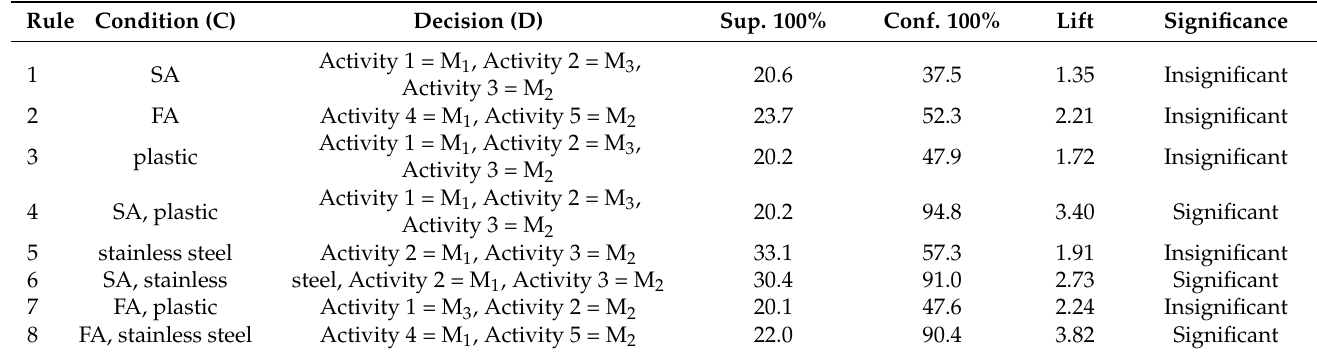
Table 16. Association rules for best patterns of each possible attribute.